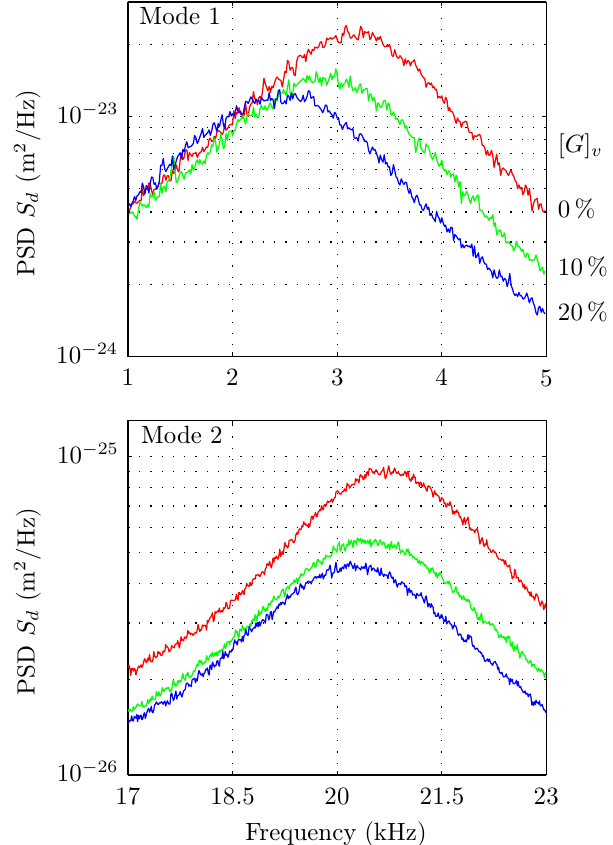
Figure 3. Zoom around the two first resonances of the thermal noise spectra of the deflection of a cantilever immersed in water-glycerol mixtures. These PSDs show increasing frequency shifts and resonances widening for increasing glycerol